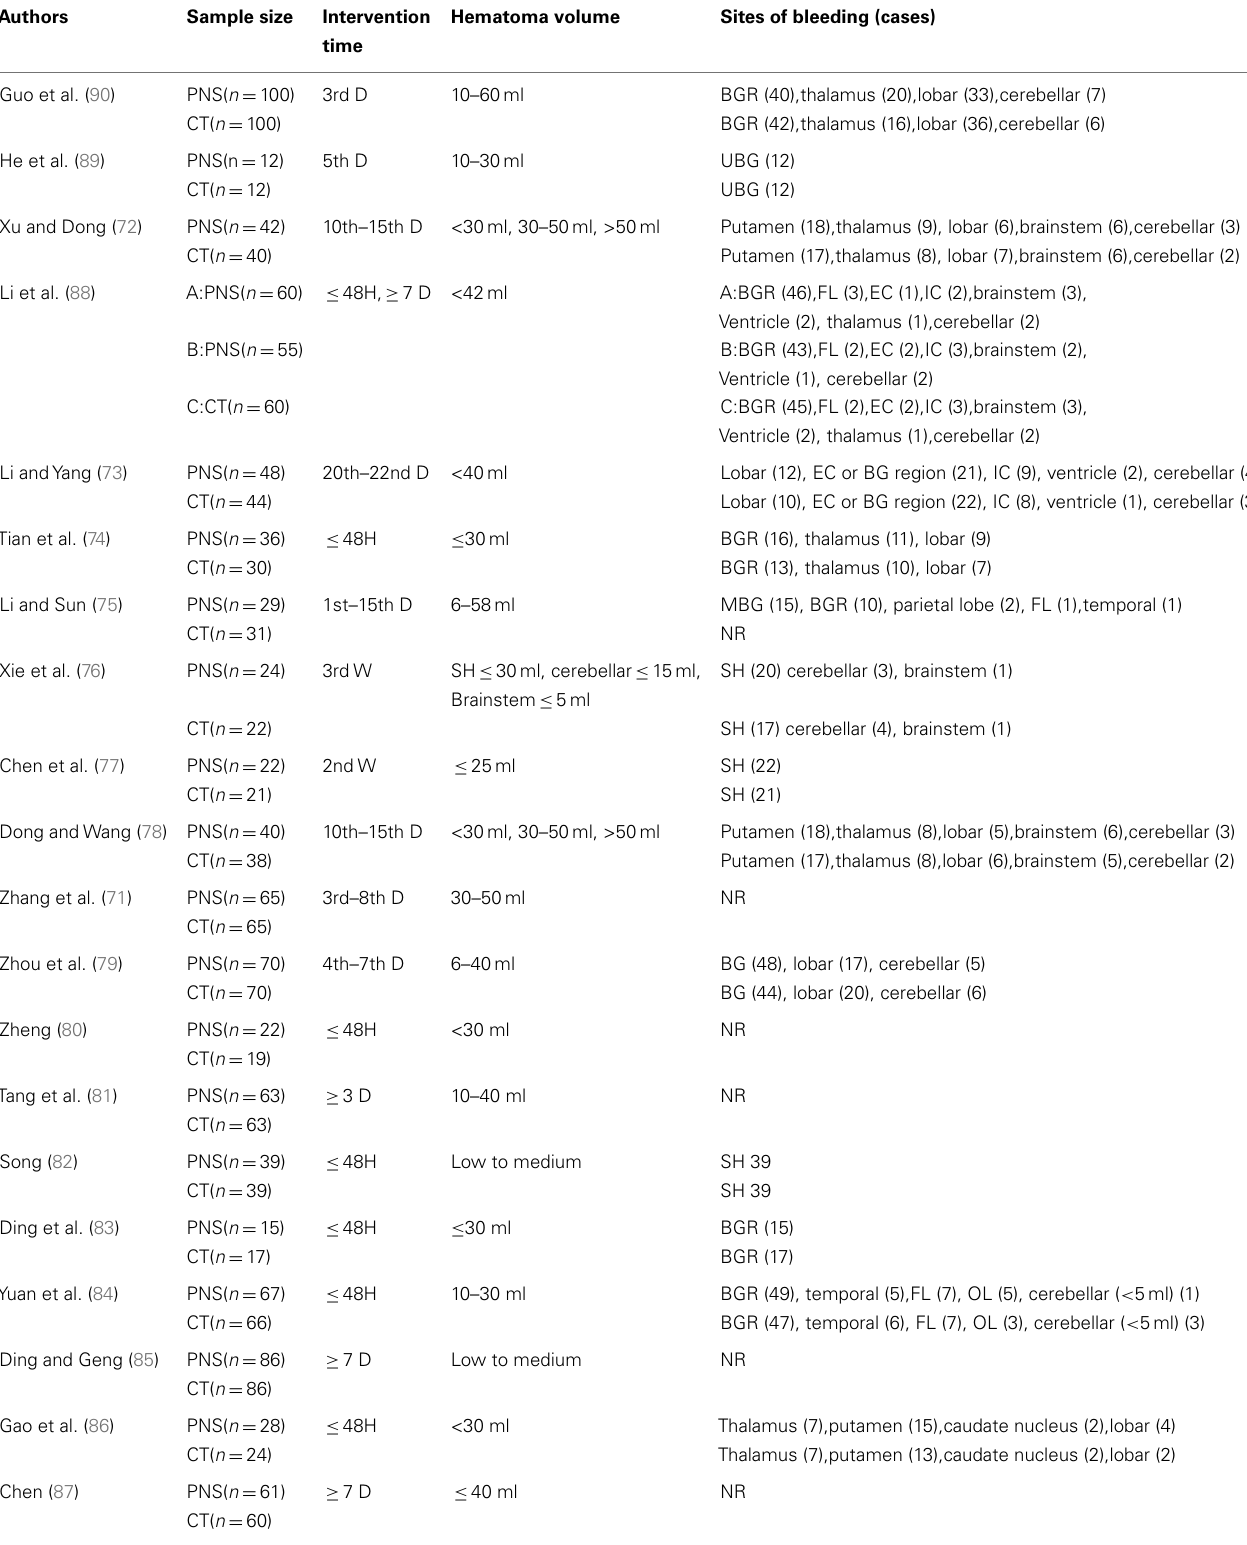
Table 3 | Detailed information of the hemorrhage sites of the 20 trials included in the meta-analyses